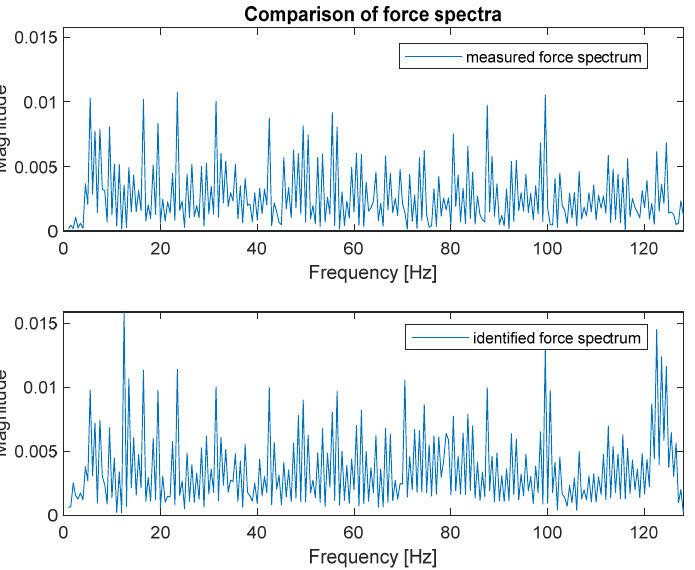
Figure 7. Comparison of measured ( top ) and identified ( bottom ) force spectra (FRF matrix inversion method).